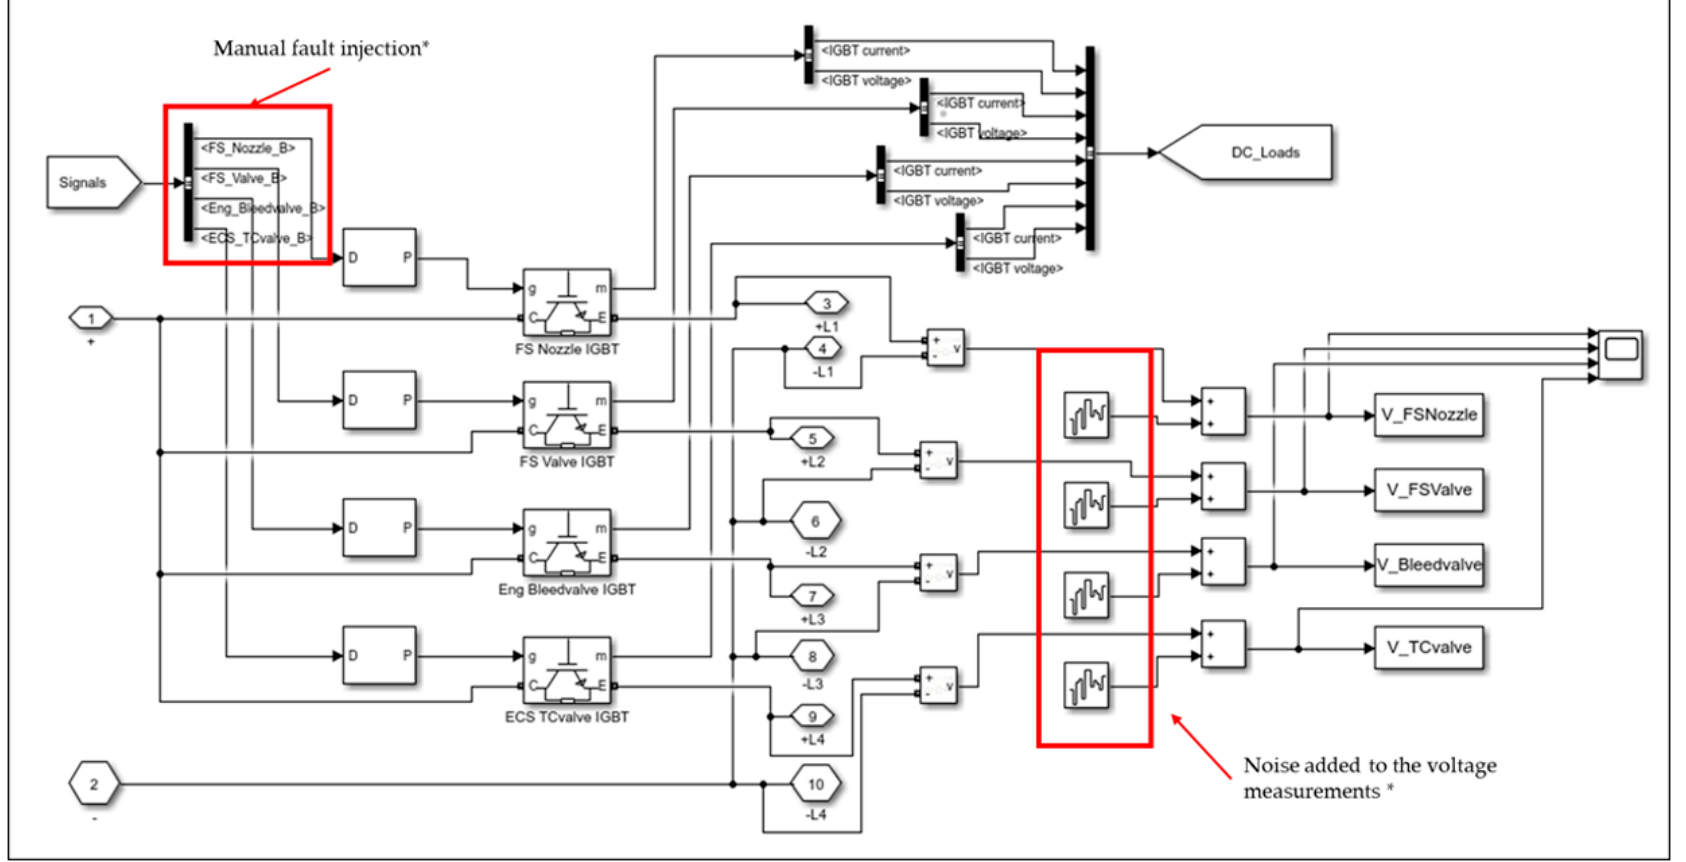
Figure 3. Fault injection to DC loads via integrated gate bipolar transistor (IGBT) switches and noise signal added to voltage measurements.